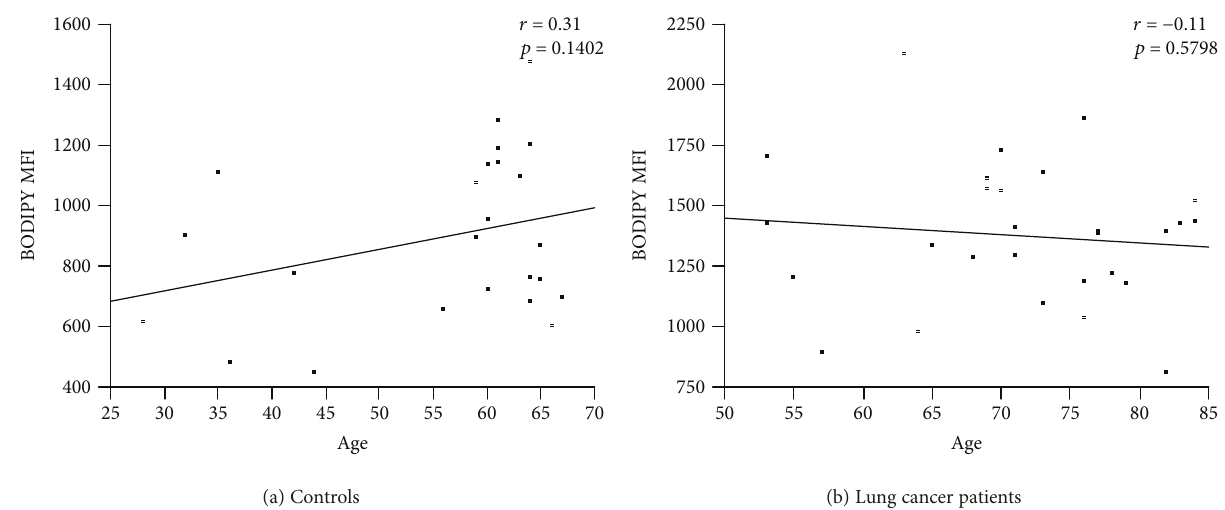
Figure 4: Correlation between age and lipid accumulation in DCs in the control group or lung cancer patient group. No signi fi cant correlation was observed between age and BODIPY MFI in DCs. The r value was 0.31 ( p = 0 1402 ) in the control group (a) and − 0.11 ( p = 0 5798 ) in the lung cancer patient group